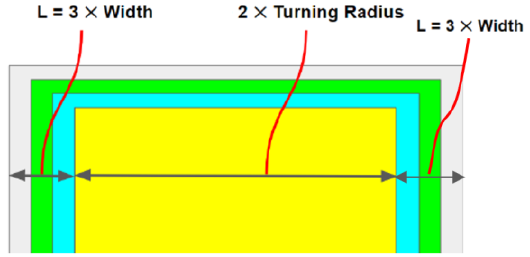
Figure 4. The minimum length to avoid merging with a neighbor subfield.